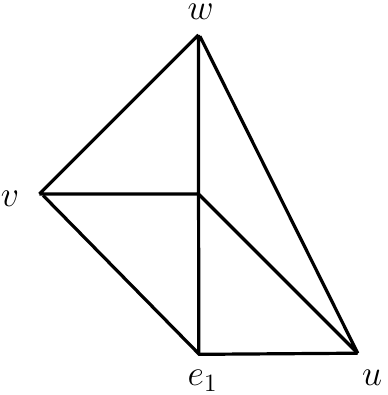
Figure 1 . The polygon F 3 describing a torus in the ambient space dP 1 .